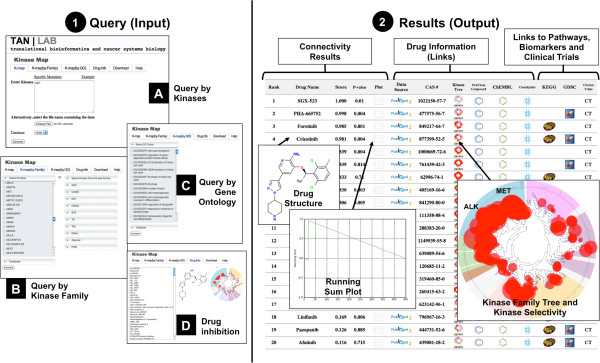
Query and results of the K-Map. Left, query features. K-Map could be
queried by: (A) direct input or directly uploading a list of kinases in
the K-Map tab, (B) by selecting kinases from the kinase family, or
(C) querying by Gene Ontology Biological Processes. All drug
information is available in the Drug Info tab (D) and could be
downloaded in the Download tab. Right, connectivity results. Query kinases were
connected to the inhibitors and sorted by normalized connectivity scores.
Link-out features include PubMed, PubChem, ChEMBL, and ChemSpider for drug
sources and information. K-Map also provides links to pathway, biomarker, and
clinical trial information for each drug via KEGG, GDSC, and ClinicalTrials.gov
databases, respectively.